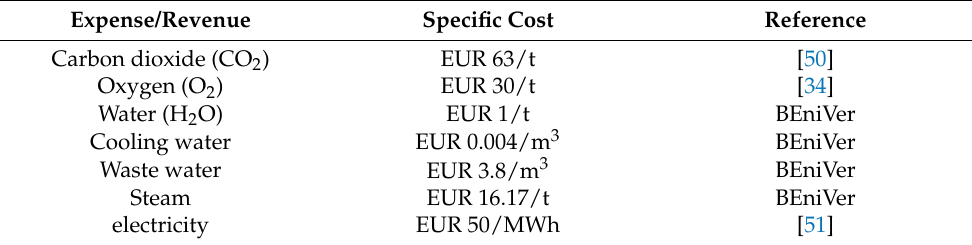
Table 5. Speci fi c costs of expenses and revenues for OPEX calculations.